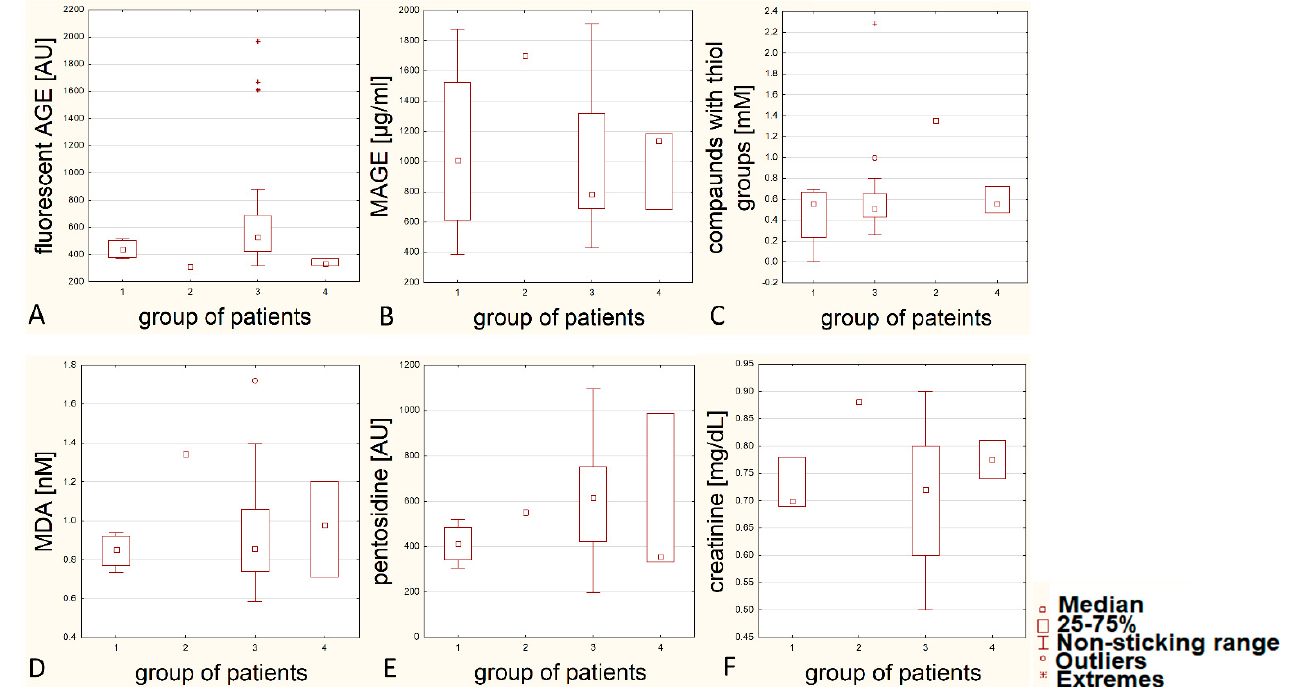
Figure 7. Comparison between patients’ groups and levels of fluorescent glycation products (panel A ), MAGE (panel B ), compounds with thiol group (panel C ), malondialdehyde (panel D ), pentosidine (panel E ) and creatinine (panel F ) in blood serum. Groups: 1—patients with papillary carcinoma, 2—patients with squamous cell carcinoma, 3—patients with goitre, 4—patients with